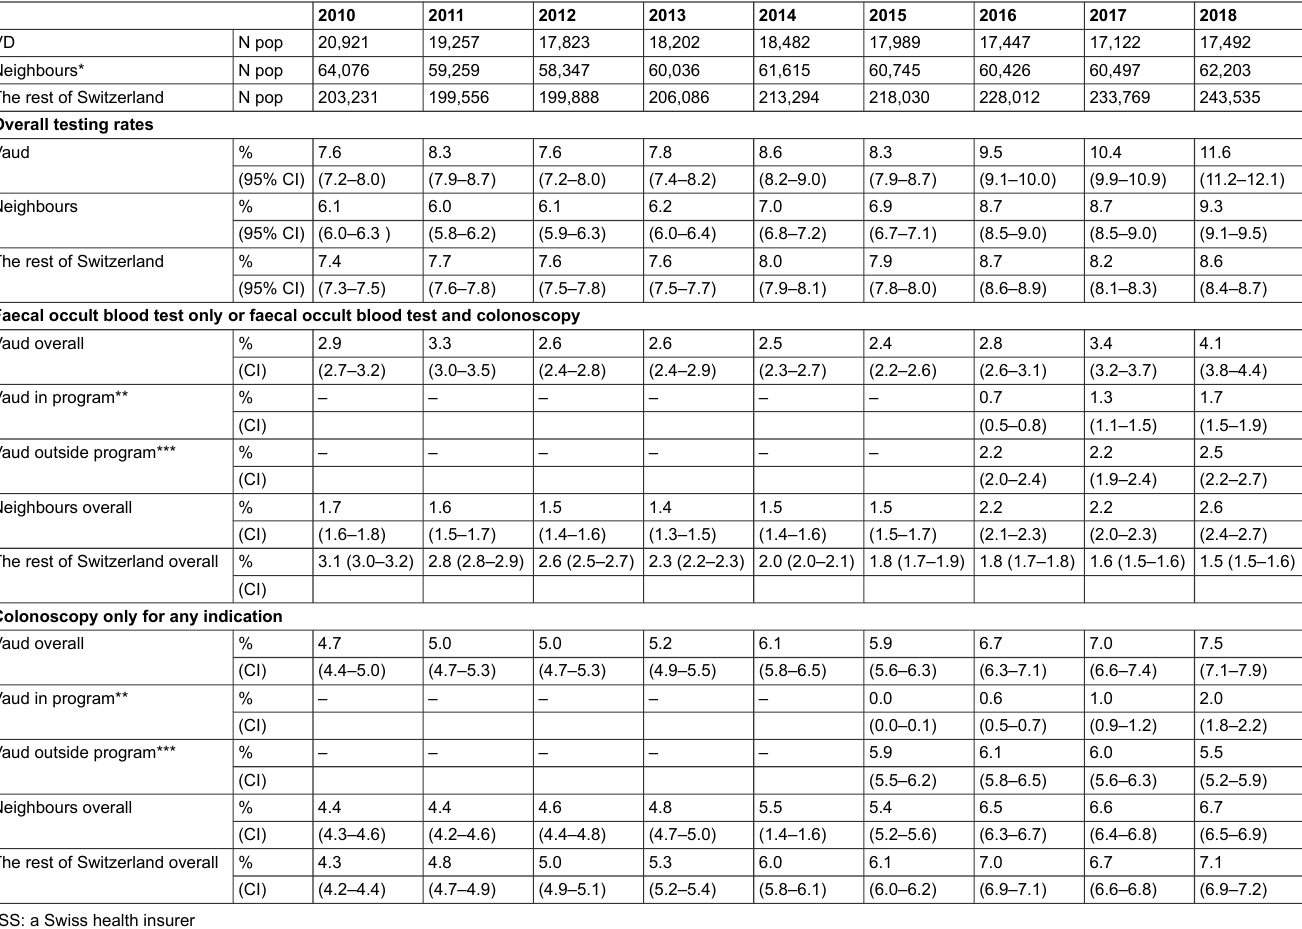
Table 2: Change in colorectal cancer testing (% of insurees tested each year), presented as overall testing rates (any test for colorectal cancer), faecal occult blood test and colonoscopy, in those aged 50–69 in Vaud, neighbouring cantons and the rest of Switzerland, between 2010 and 2018. The organised screening programme began at the end of 2015 in Vaud. CSS database years 2010 to 2018. Exclusion criteria: moved, died or changed insurance during each